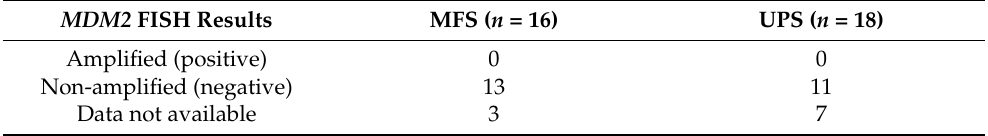
Table 1. Results of MDM2 FISH analysis performed on MFS and UPS cases. MDM2 FISH Results MFS ( n = 16)